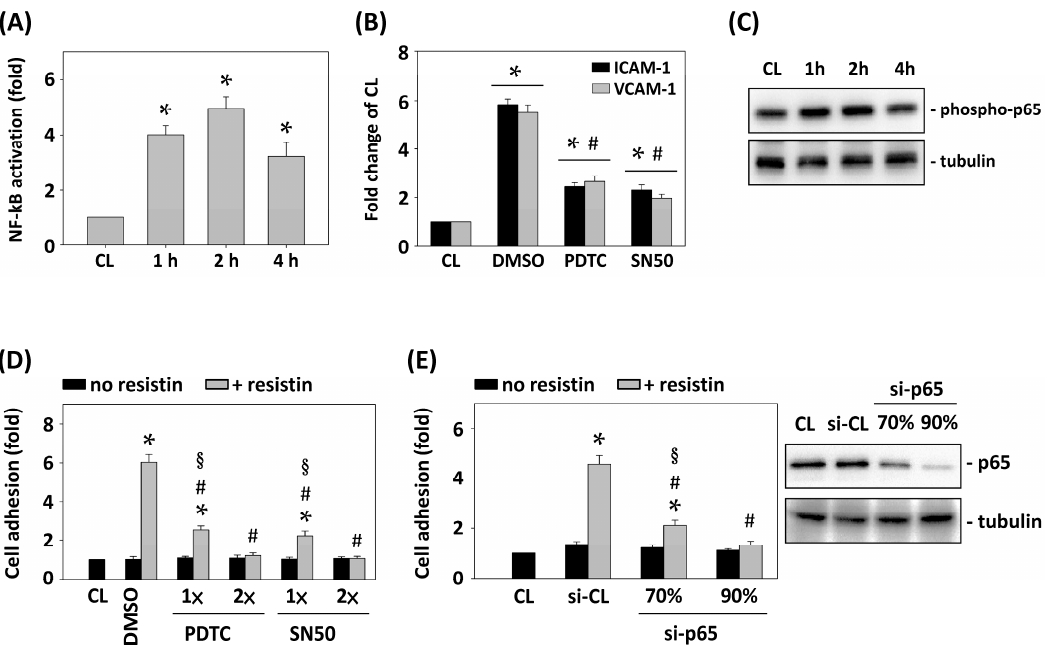
Figure 4. Resistin-initiated HCT-116 adhesion to HUVECs is mediated by NF- κ B activation. ( A ) and ( C ) HCT-116 cells were maintained as control or stimulated with resistin for 1, 2, and 4 h and then NF- κ B activation ( A ) and p65 phosphorylation ( C ) were determined by ELISA kit and Western blot, respectively; ( B , D , E ) HCT-116 cells were pretreated with ( B , D ) DMSO or NF- κ B inhibitors (PDTC or SN50) and ( E ) control or p65 specific siRNA and then stimulated with resistin. HCT-116 cell adhesion and ICAM-1/VCAM-1 mRNA expression were analyzed. Data represent the mean ± SEM from three independent experiments. * p < 0.05 vs. control cells; # p < 0.05 vs. DMSO or si-CL cells with resistin treatment; § p < 0.05 vs. PDTC, SN50, or si-p65 cells without resistin treatment.